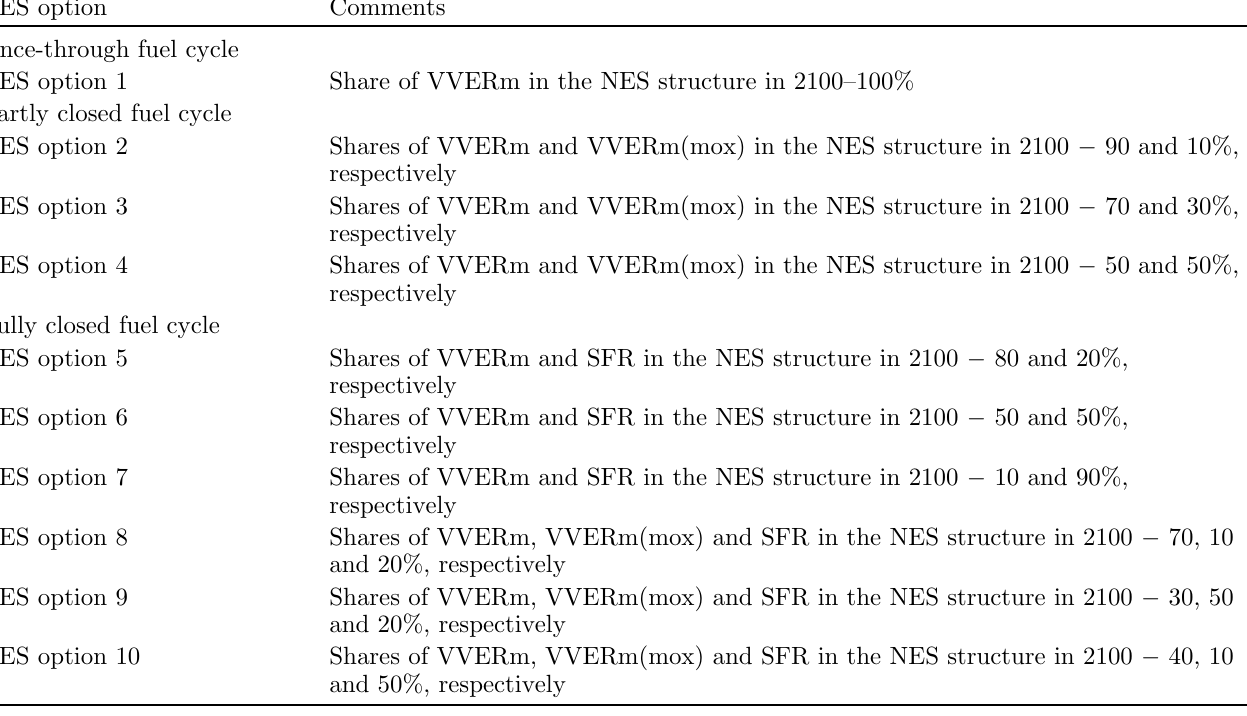
Table 1. Considered NES